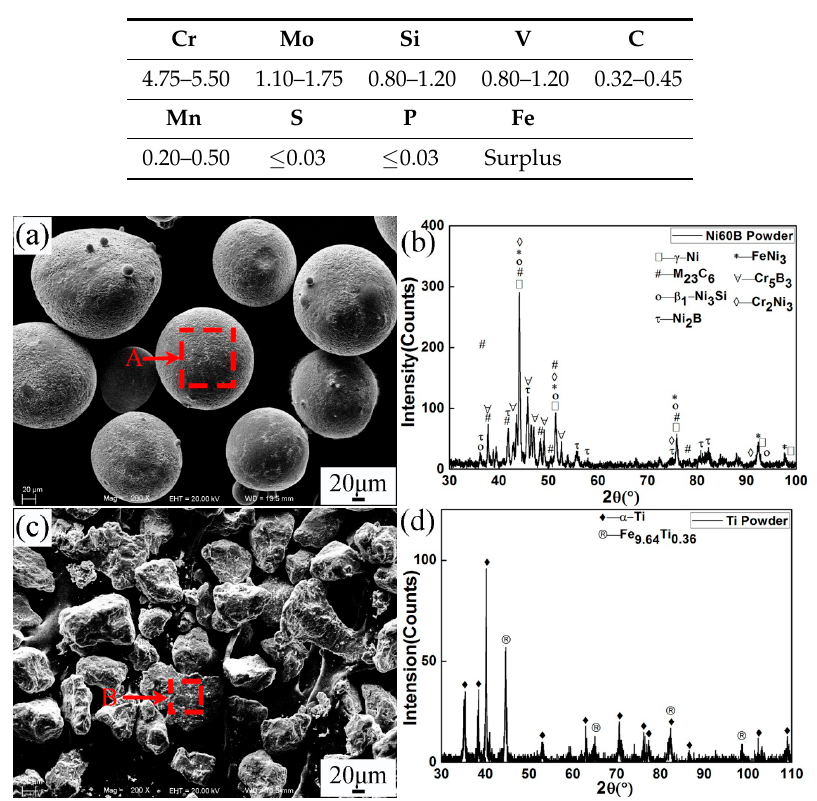
Table 1. H13 Chemical compositions (wt %).